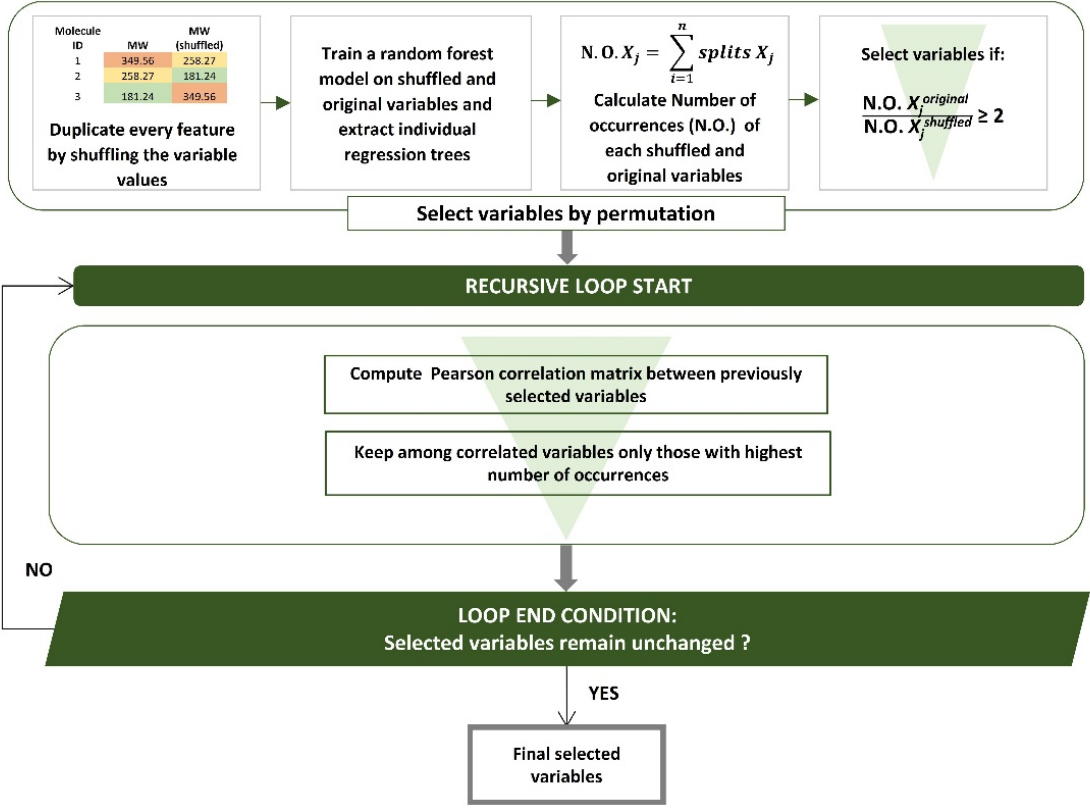
Figure A2. Recursive variable selection workflow. Number of occurrences (N.O.).